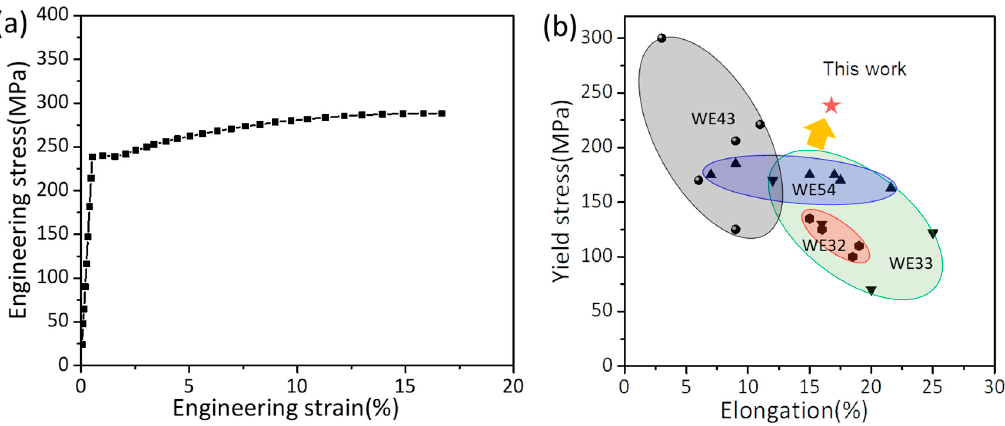
Figure 3. Mechanical properties of the extruded alloy at room temperature. ( a ) Engineering stress– strain curve; ( b ) comparison of the elongation and yield stress of different extruded WE alloys [14,31–38] .